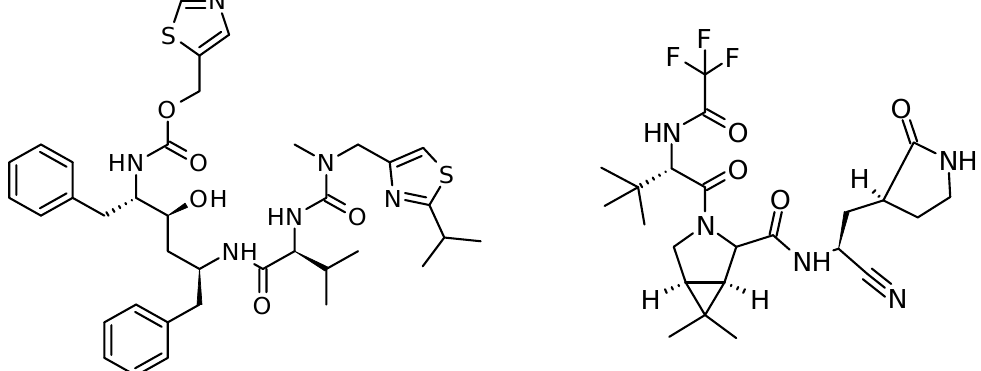
Figure 1. Chemical structure of Ritonavir ( left ) and Nirmatrelvir ( right ), both composing Paxlovid ® , clinically employed for the treatment of COVID-19.